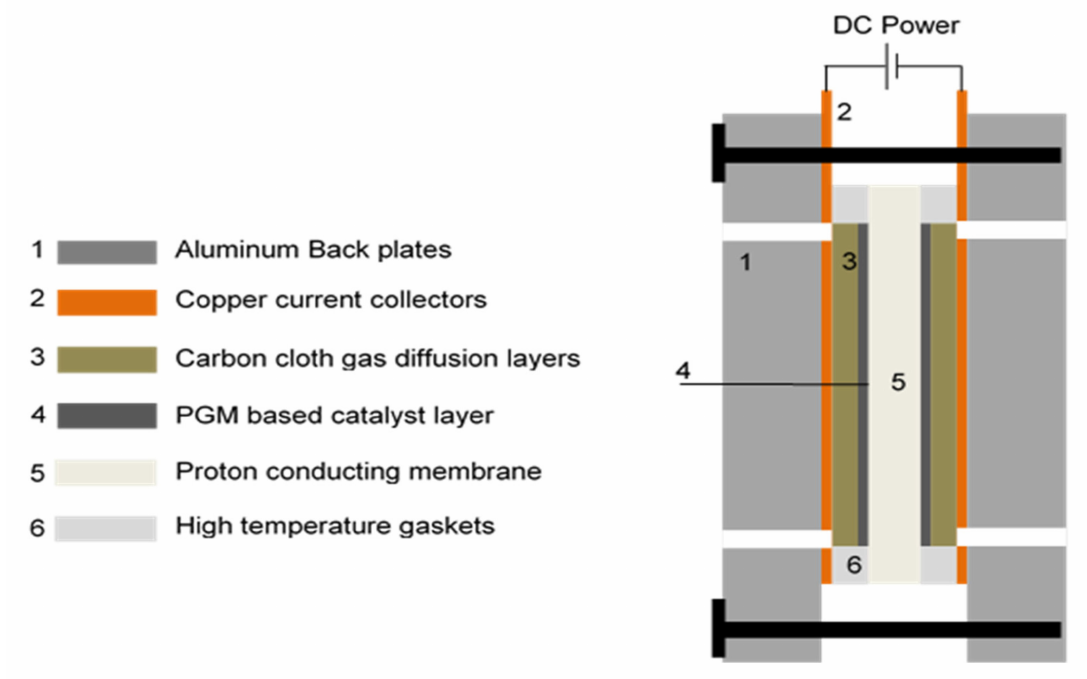
Figure 2. Cross section of the electrochemical